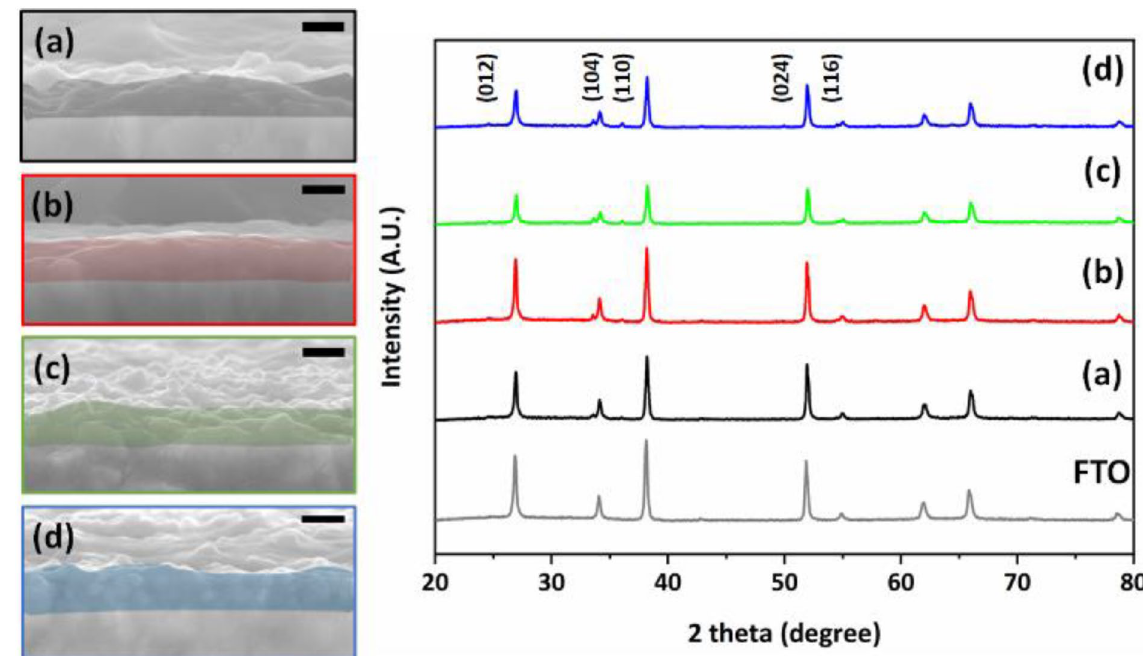
Figure 1. Typical SEM images and X-ray diffraction patterns of pristine hematite thin film ( a , black) and Cu 2+